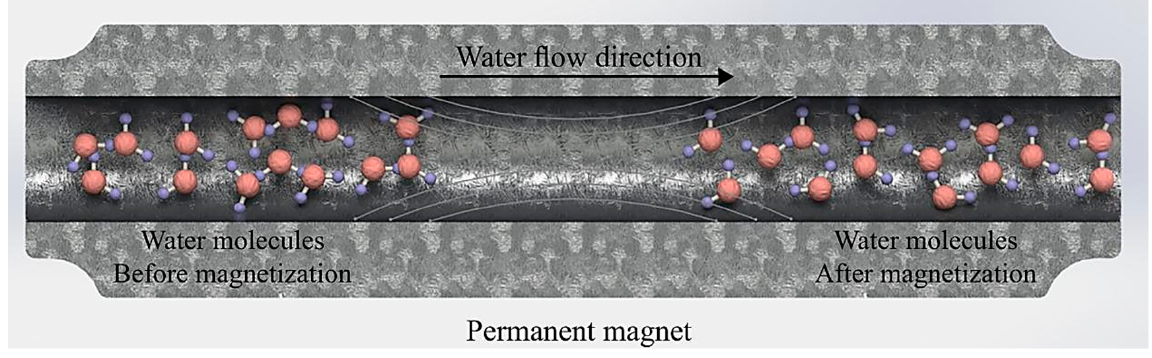
Figure 1. Water molecules before and after magnetization [17].